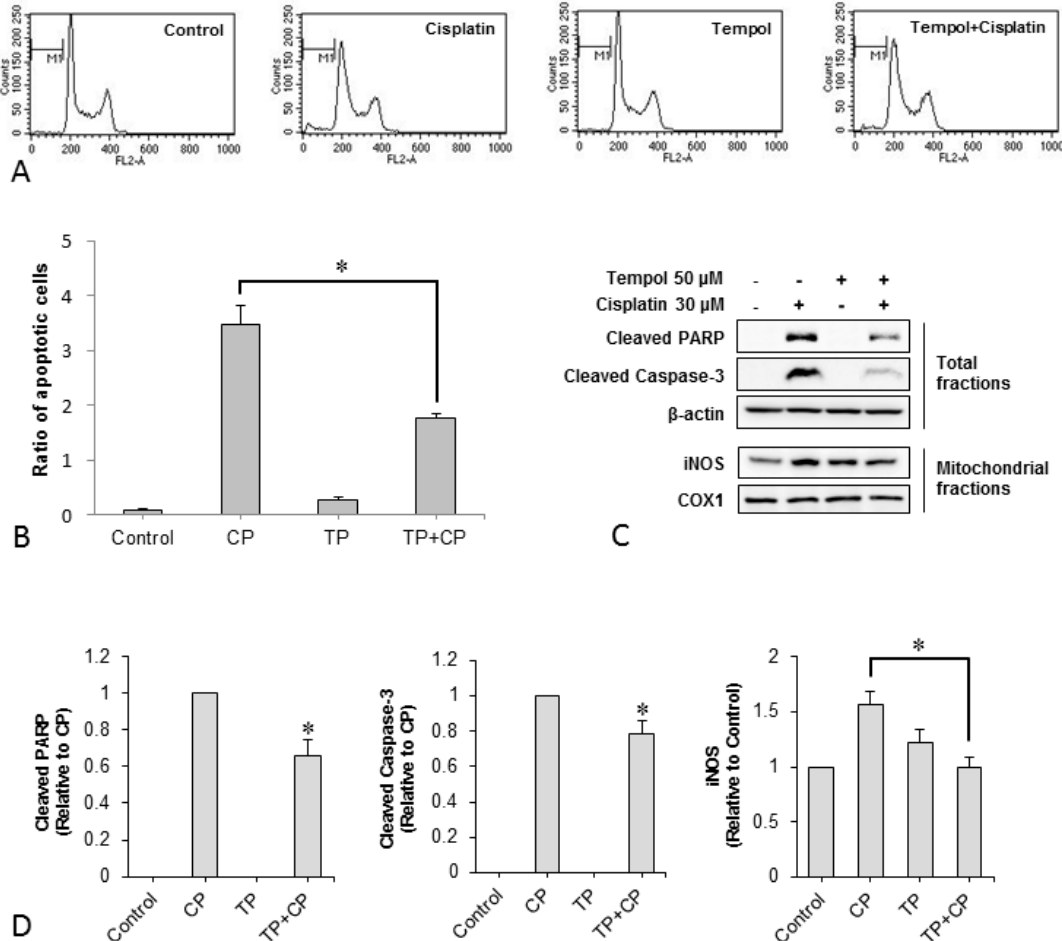
Figure 3. The ratio of apoptotic cells was determined using flow cytometry and representative histograms are illustrated ( A ). Apoptotic cells were reduced by 2-h pre-treatment with 50 µ M Tempol before cisplatin exposure for 24 h ( B , * p < 0.05 compared to cells treated with cisplatin alone, paired Student’s t -test). Expression of cleaved PARP, cleaved caspase-3, and iNOS increased in the cisplatin- treated group. However, Tempol inhibited the cisplatin-induced increase in expression of cleaved PARP, cleaved caspase-3, and iNOS. ( C , D , * p < 0.05, paired Student’s t -test). Each group was tested